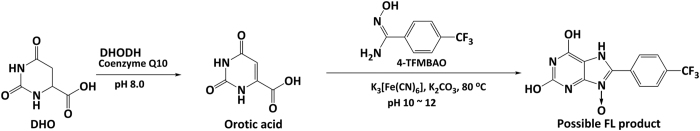
Principle of the FL assay for DHODH activity.Orotic acid is first produced from an excess of DHO substrate along with a small amount of DHODH in a sample. It is then chemically converted into a FL compound with 4-TFMBAO.